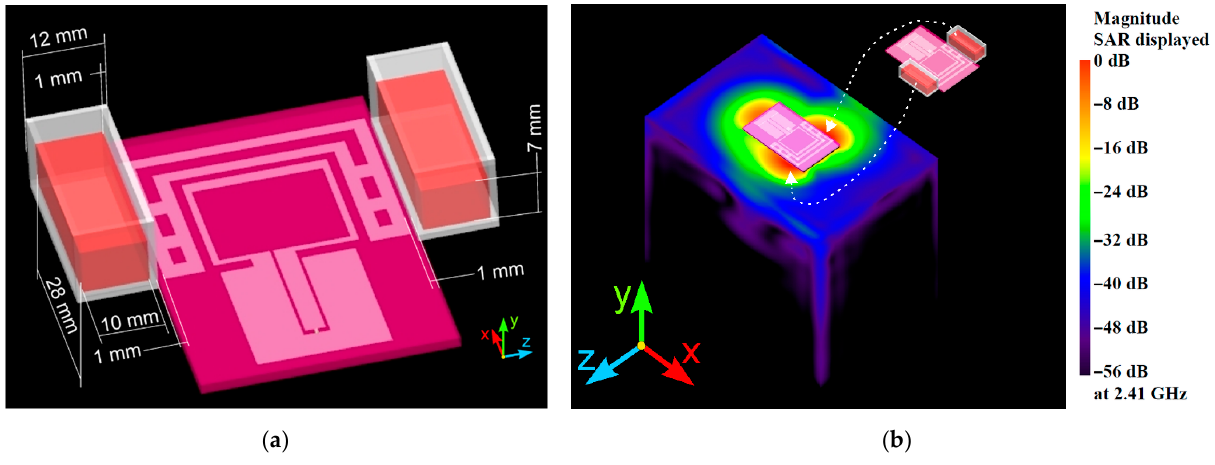
Figure 2. Numerical models of ( a ) wearable antenna, cuvettes, and erythrocyte suspension, and ( b ) flat homogeneous phantom and SAR distribution on the surface of the phantom induced from the wearable textile antenna, as incorporated in the FDTD model.